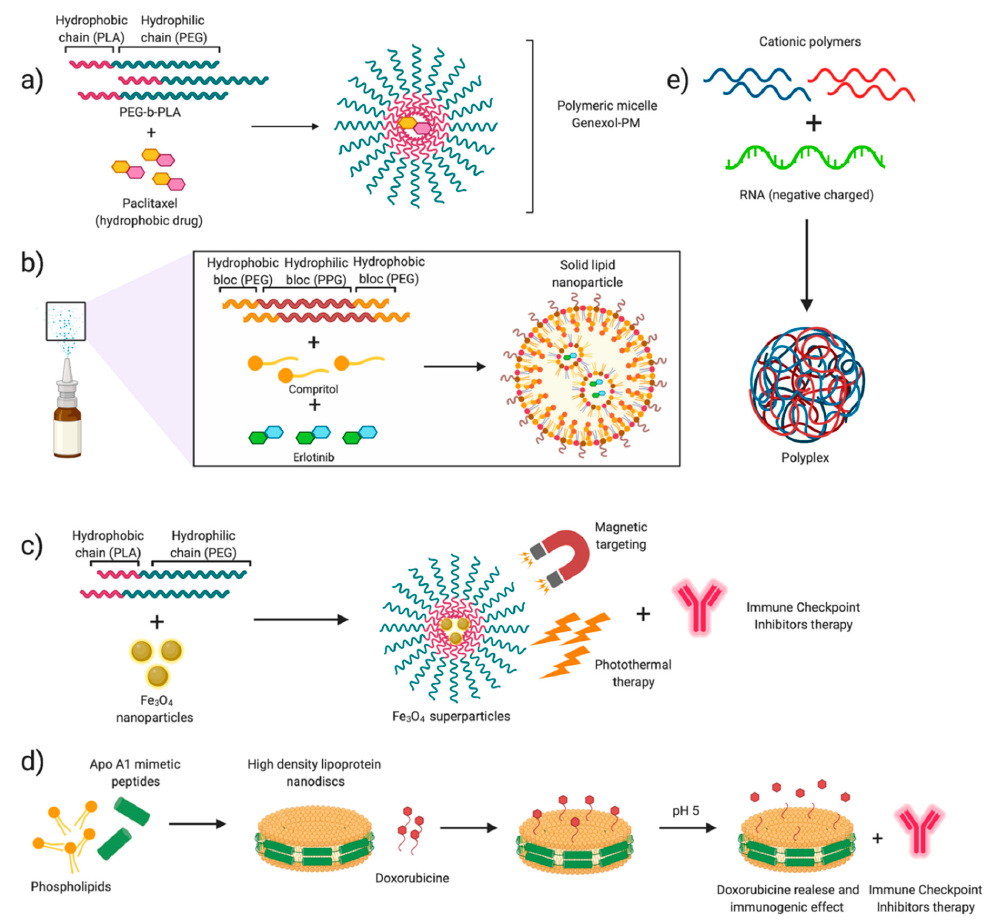
Figure 8. Nanotechnology for NSCLC. Summary of the mentioned examples describing different encapsulation systems. ( a ) Poly(ethylene glycol)–b-poly(lactic acid) (PLA–b-PEG) nanoparticles encapsulating Paclitaxel (Genexol-PM ® ) (NCT01023347, NCT01770795). ( b ) Solid–lipid nanoparticle formation for Paclitaxel encapsulation [99]. ( c ) Supernanoparticles for photothermal therapy in combination with Immune Checkpoint Inhibitors (ICIs) immunotherapy [119]. ( d ) Assembly of high-density-lipoprotein nanodiscs for doxorubicin delivery [115]. ( e ) Encapsulation of RNA in polyplexes, formed by cationic polymers [144–146].